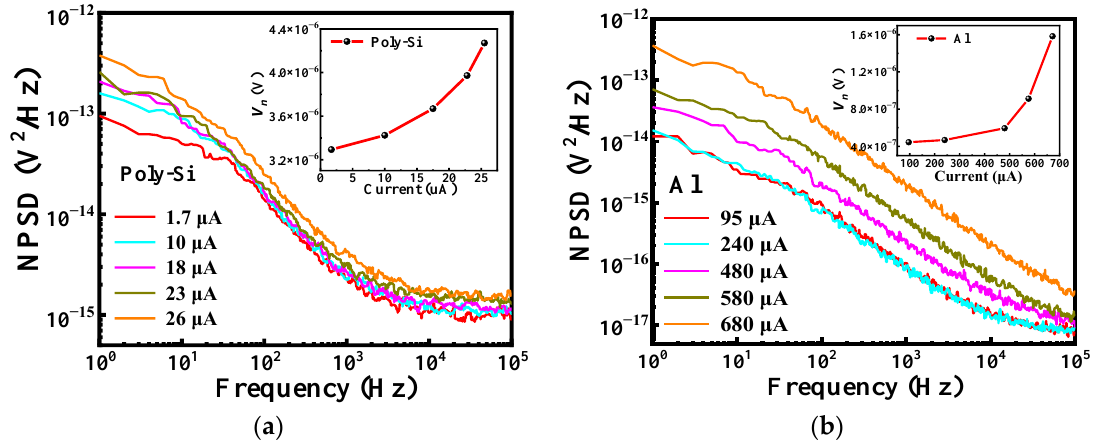
Figure 7. The noise power spectral density of ( a ) the salicide polysilicon microbolometer and ( b ) metal Al microbolometer under the vacuum condition at different bias currents. The inset shows bias currents dependence noise voltage of under the bandwidth of 10 kHz.